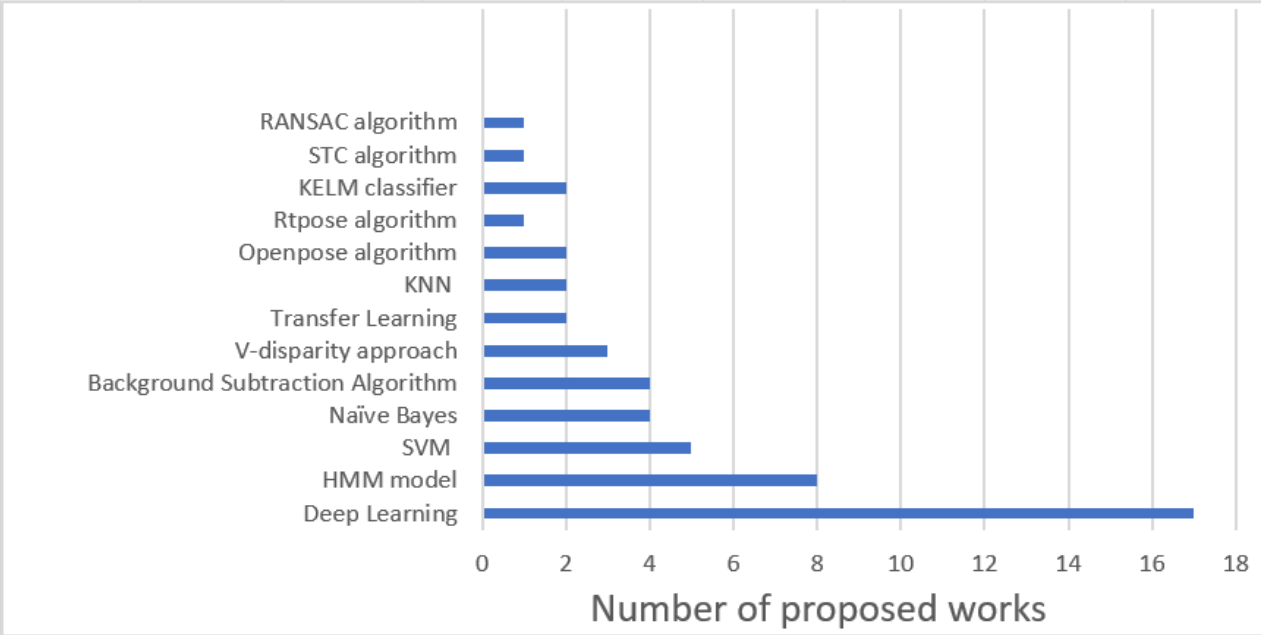
Figure 4. Different Computing Techniques used from the last